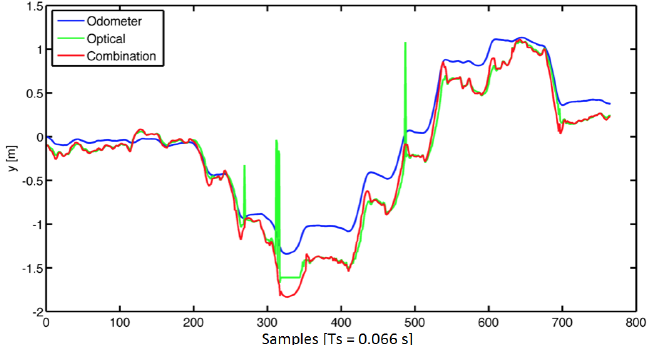
Figure 6. Position values in an open loop obtained from the image processing (green), the odometry (blue) and the fused response